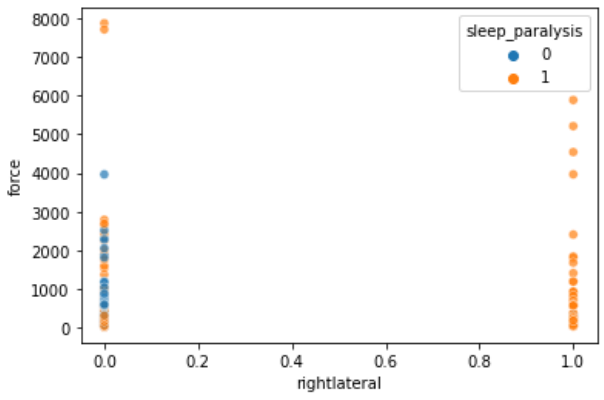
Figure 16. Right Lateral vs Sleep